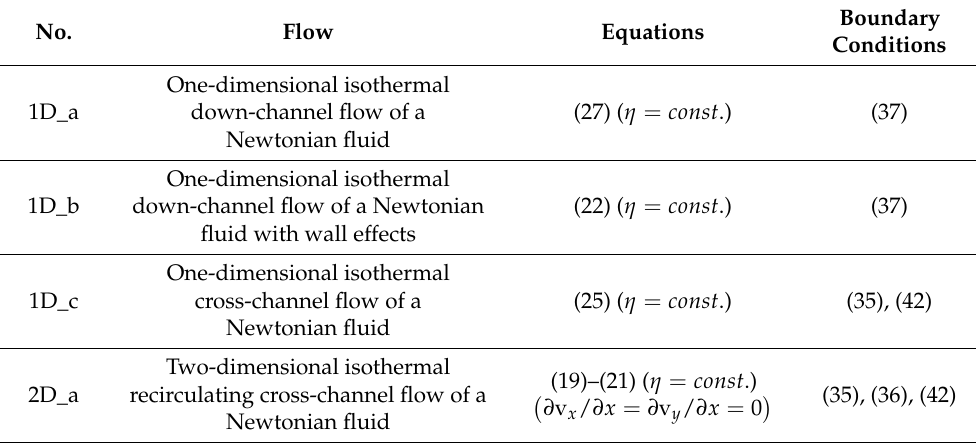
Table 1. Mathematical models of extruder flow of Newtonian fluids with temperature-independ- ent